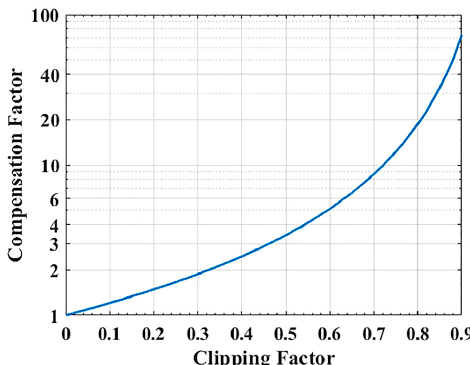
Figure 6. Compensation factor for the power loss of focused data, which is caused by the saturation of raw data. The clipping factor is calculated in saturated raw data, the real and imaginary parts of which follow a zero-mean Gaussian distribution.